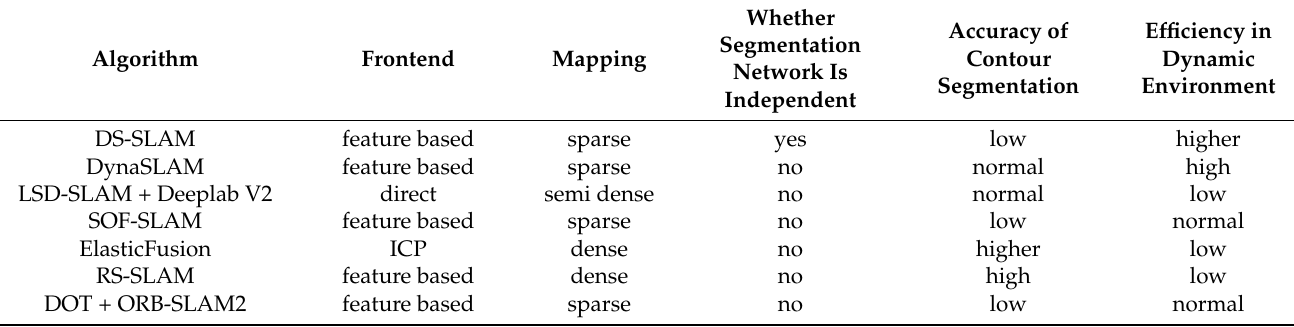
Table 2. The evaluation of existing visual SLAM based on dynamic feature point